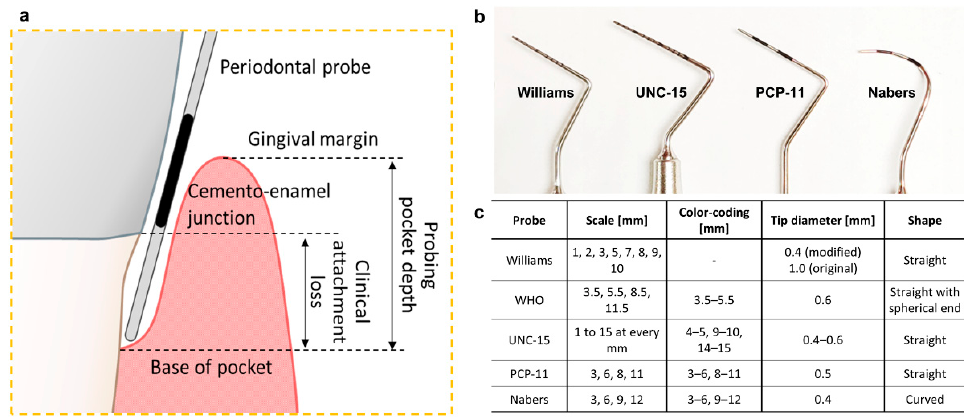
Figure 1. ( a ) Schematic presenting the measurement of PD between the tooth and gingiva using a periodontal probe with distance markings. ( b ) Various types of commonly used manual periodontal probes and ( c ) specifications [19].